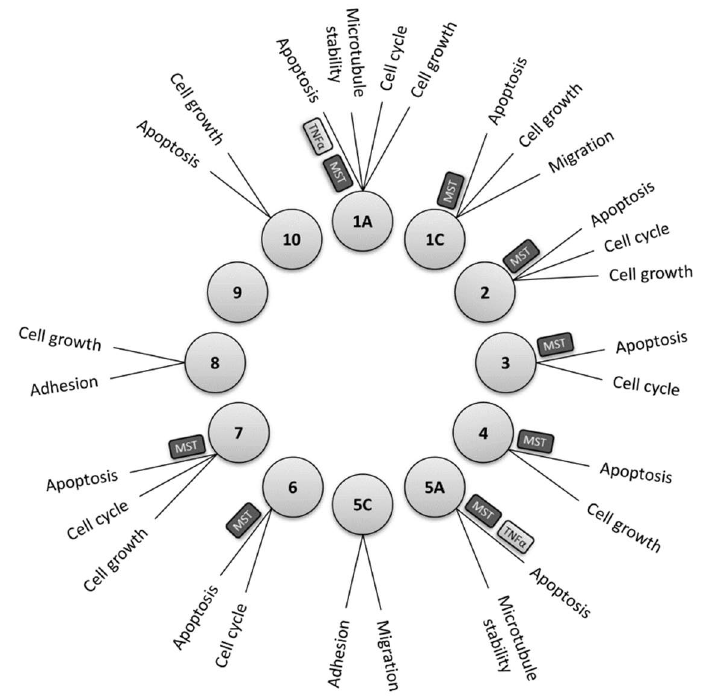
Figure 2. The major known cellular processes governed by each of the RASSF family proteins. Links to the Hippo (MST) and TNF-α signalling pathways are shown for relevant isoforms.